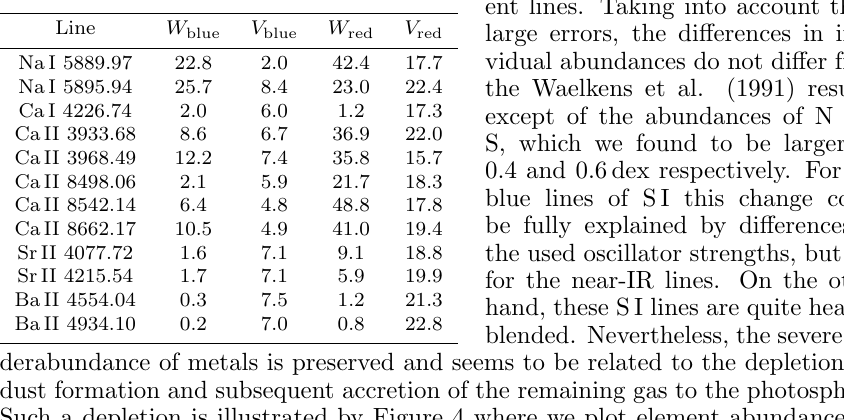
Fig. 4. Dependence of element abundances in HD 52961 on the element condensation temperature T cond (Lodders 2003). Table 3. Equivalent widths [pm] and he- liocentric velocities [km s − 1 ] of the split line components in the spectrum of HD